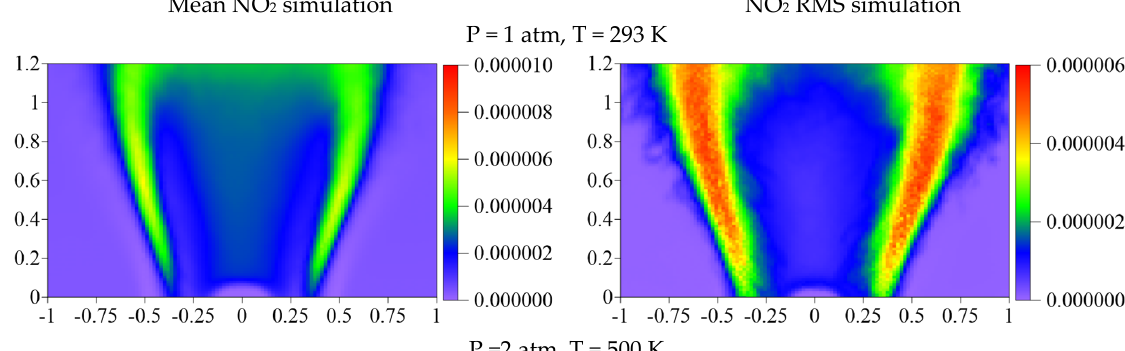
Figure 9. Mean NO concentration fields and RMS of the concentration fluctuations evaluated by the LES approach.